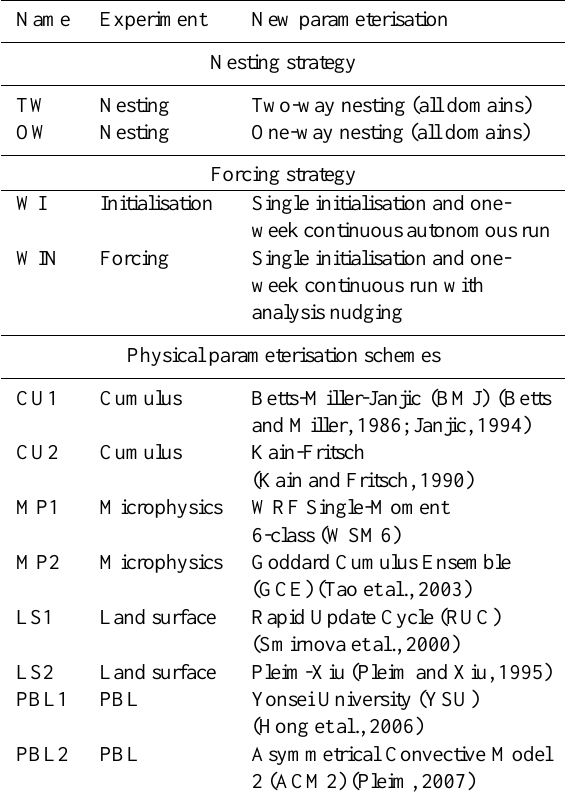
Table 4. Design of the sensitivity experiments.